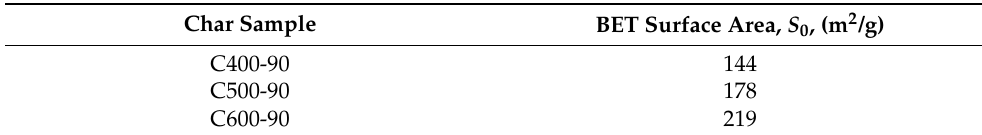
Table 2. BET surface area of chars derived from CO 2 adsorption at 0 ◦ C for chars prepared at different carbonization temperature of 400, 500 and 600 ◦ C.